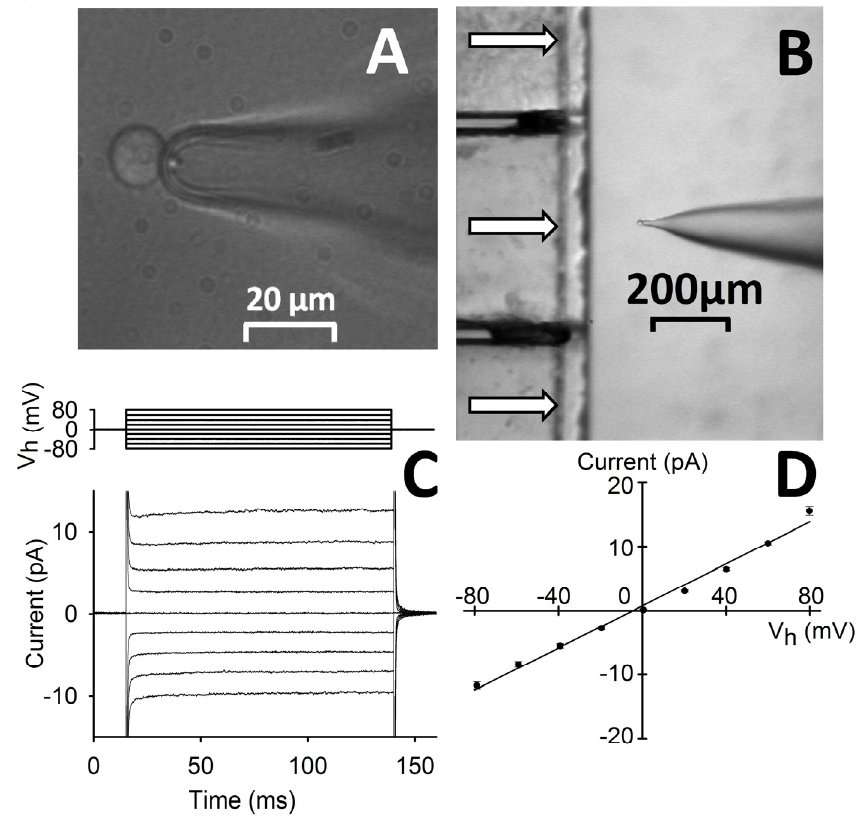
Figure 1. Outline of the technique employed. ( A ) CHO-K1 cell recorded in whole-cell with a pressure-polished pipette; cell is aligned in front of the perfusion pipette (at low magnification in ( B ) formed by square glass capillaries (500 µm of side) glued together; horizontal arrows denote perfusion flows. ( C ) Average whole-cell current recorded from representative cells ( lower panel ; pipette and external solution: 130 mM K + + 1 mM Ca 2+ ), subjected to 125 ms voltage steps from − 80 mV to +80 mV in 20 mV increments ( top panel ) starting from V = 0 mV (traces are the average of n = 6 cells); ( D ) the average h current evoked by each voltage step of C is plotted against the voltage step amplitude; the points are well fitted by a straight line (correlation coefficient ~0.99), whose angular coefficient gave R ~6.1 G Ω m